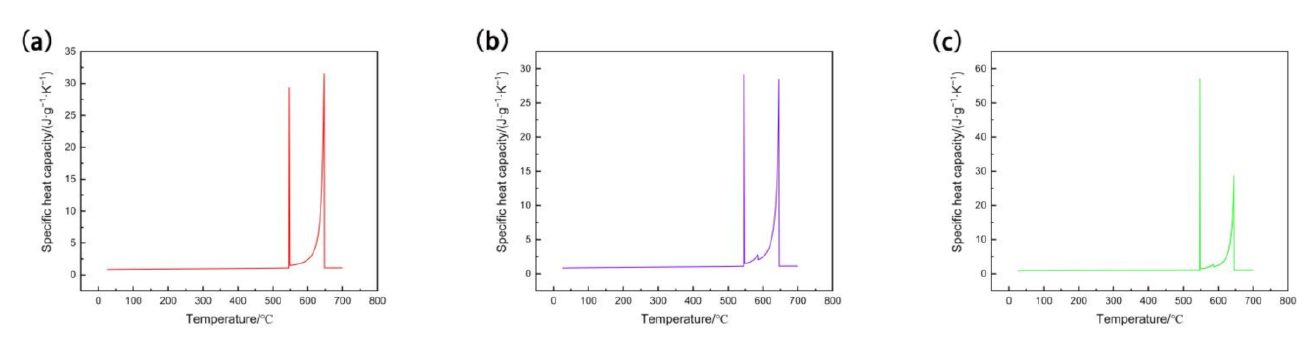
Figure 8. Variation trend of specific heat capacity of ( a ) Al-Cu, ( b ) Al-Cu-La, ( c ) Al-Cu-La-Sc alloys with temperature in equilibrium solidification